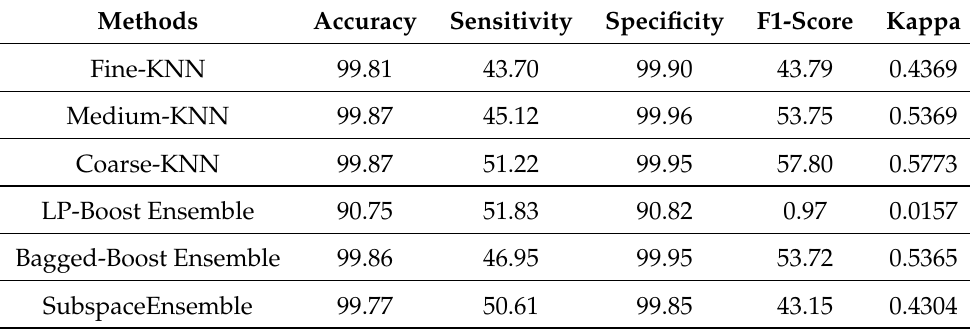
Table 7. Results of 10-fold predictions using deep